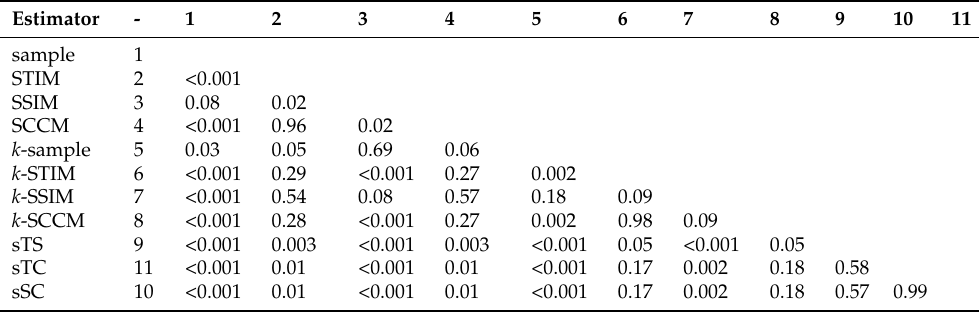
Table A6. p -Value of the portfolio turnover for each pair of covariance estimators in Table